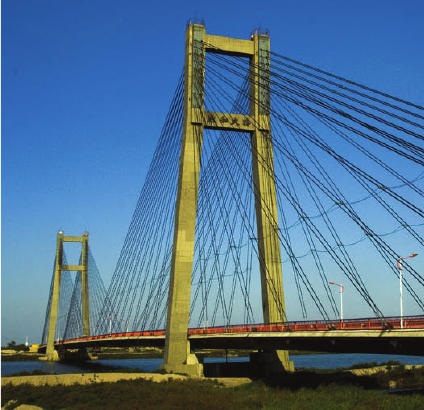
Figure 1: Overview of the cable-stayed